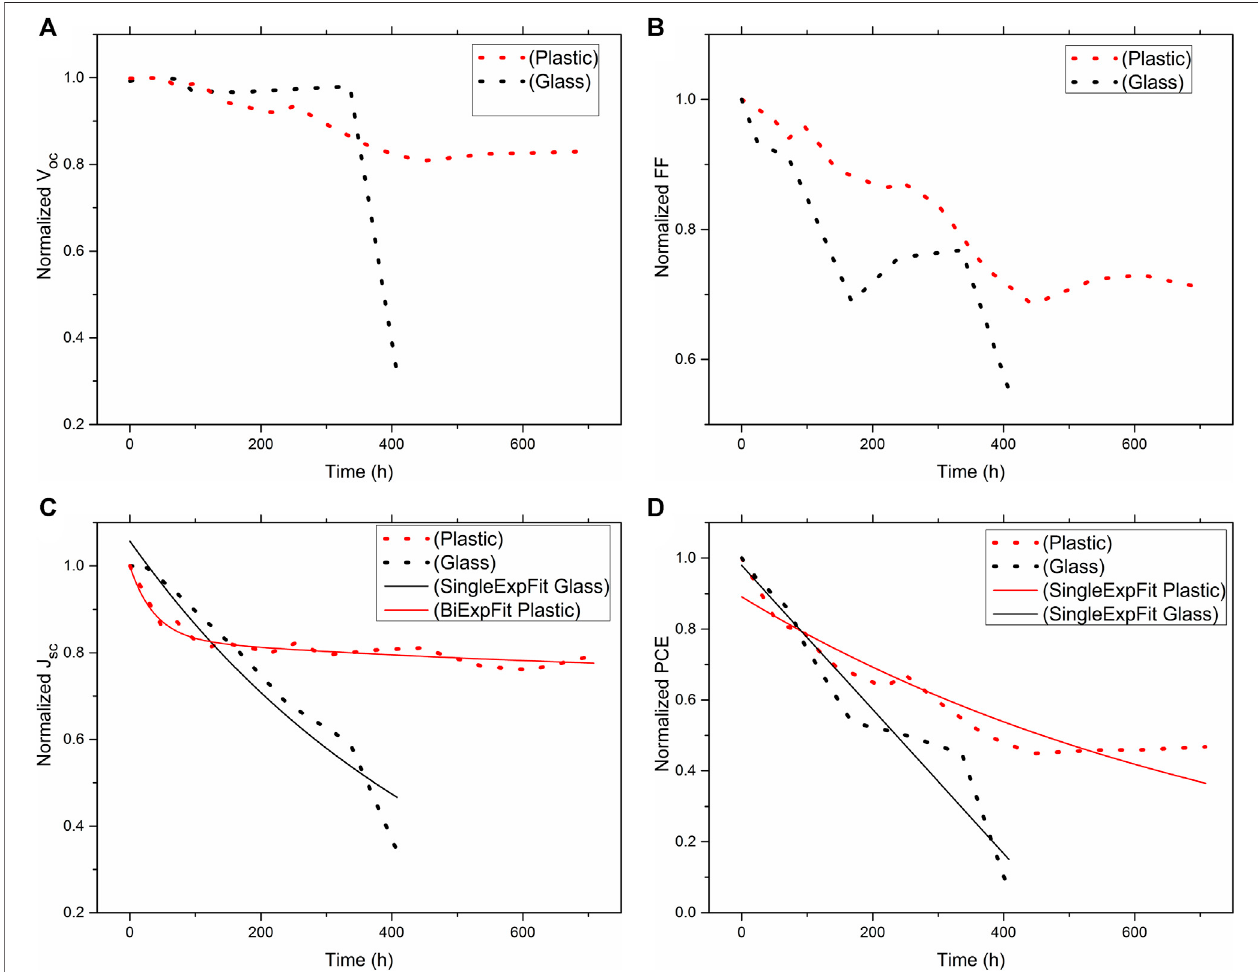
FIGURE 4 | Evolution of the OSC electrical parameters (Voc (A) , FF (B) , Jsc (C) and PCE (D) ) vs. time (glass and plastic encapsulation) for the thermal chamber (ISOS-T-3).